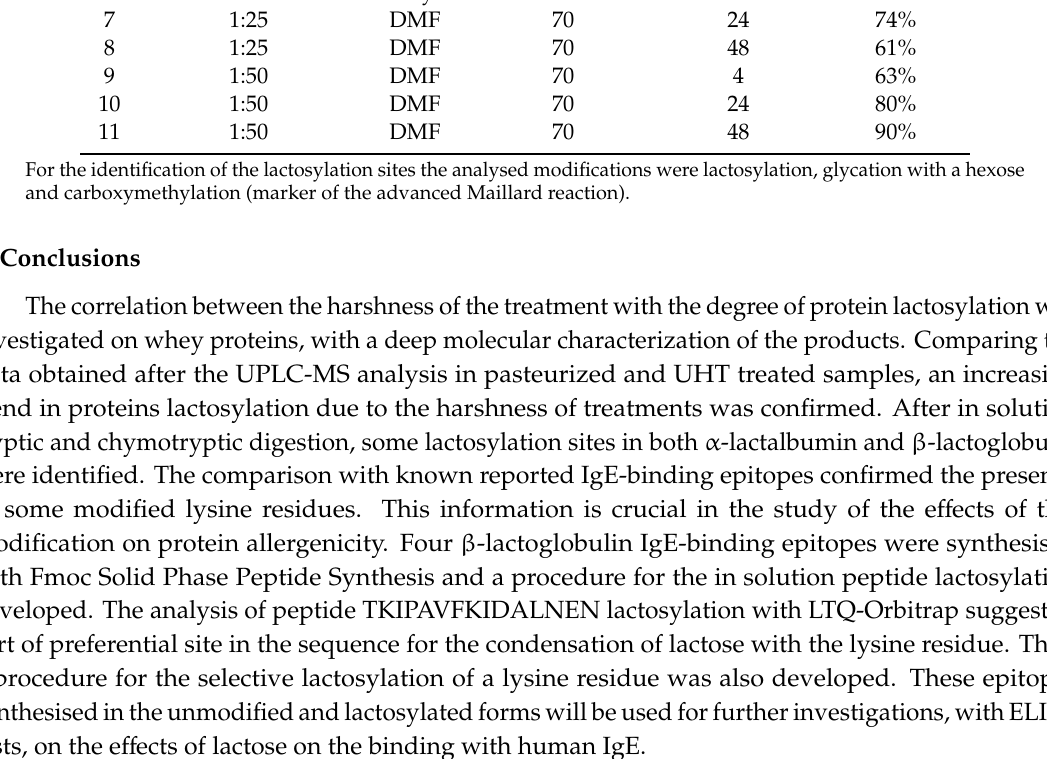
Table S1: List of the identified α -lactalbumin peptides with glycated lysine residues after tryptic and chymotryptic in solution digestion, Table S2: List of the identified β -lactoglobulin peptides with glycated lysines after tryptic and chymotryptic in solution